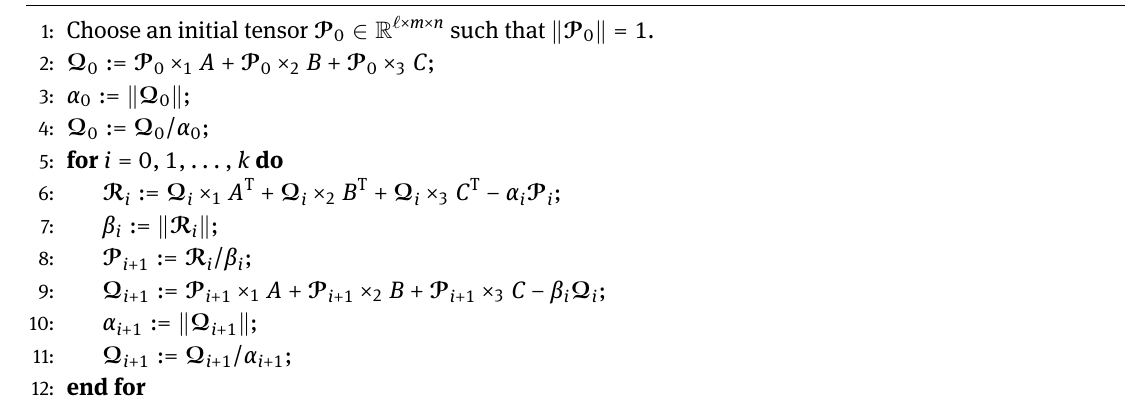
Algorithm 1 The Lanczos bidiagonalization method over tensor space for